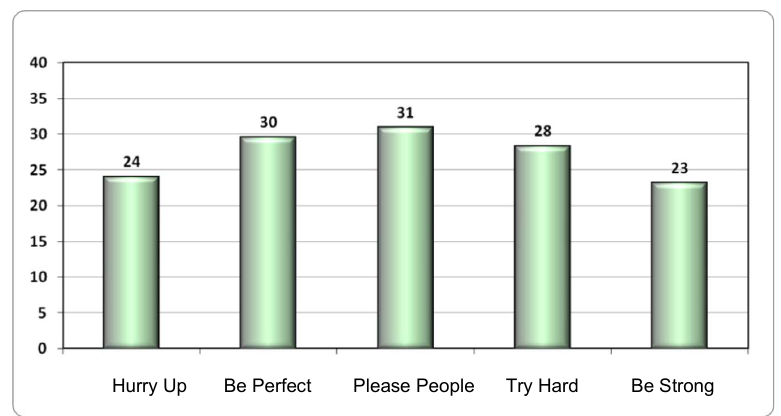
Figure 1. Presence of the five working styles in the profession Economist